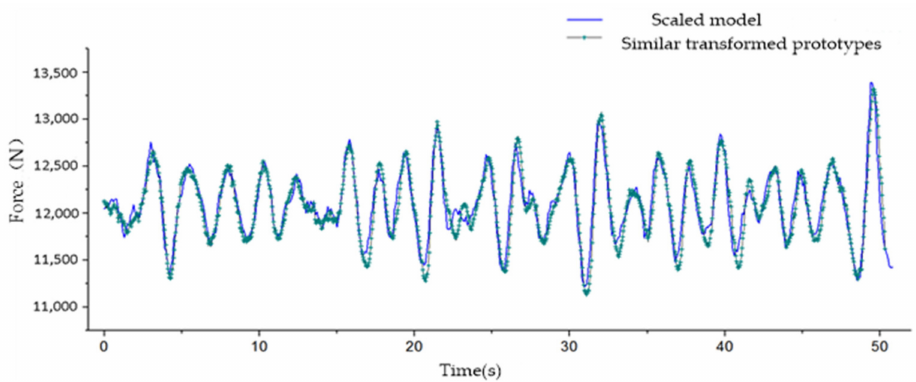
Figure 6. Force comparison between tower and deck articulation during pipe